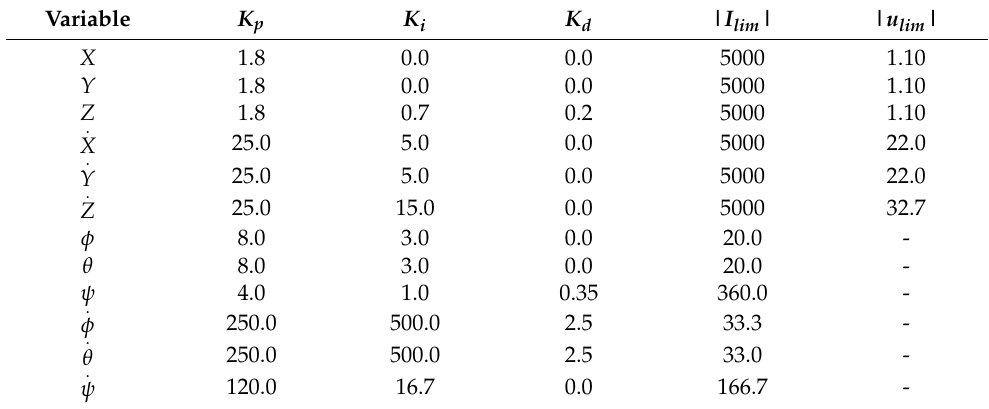
Table 1. Gains of the PID